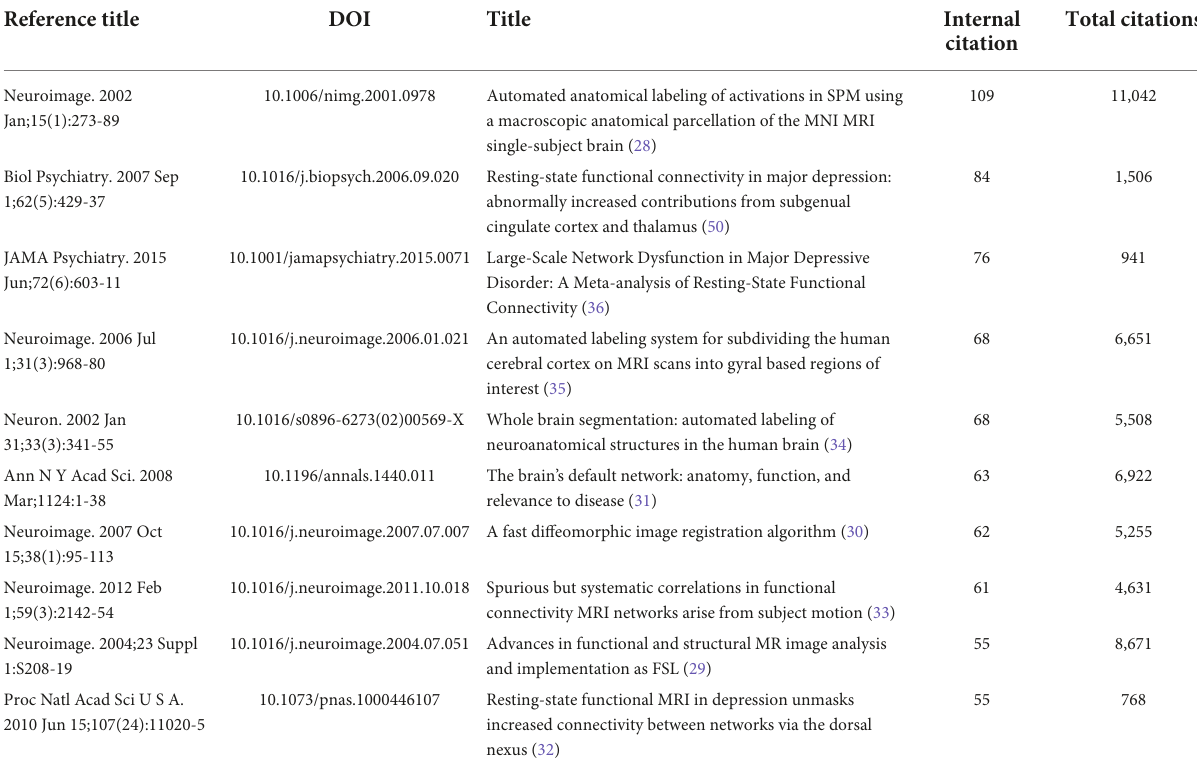
TABLE 4 Top 10 cited publications of major depressive disorder (MDD) and